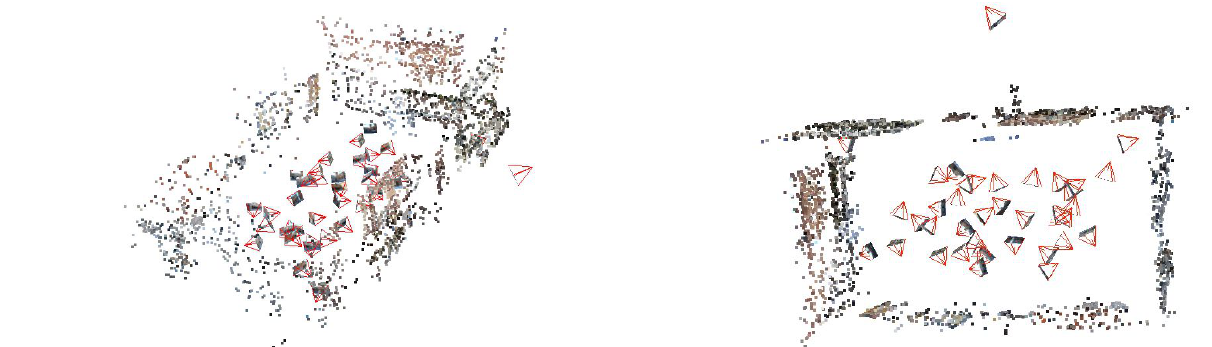
Figure 4: Two views of the reconstruction of “Piazza Dante”